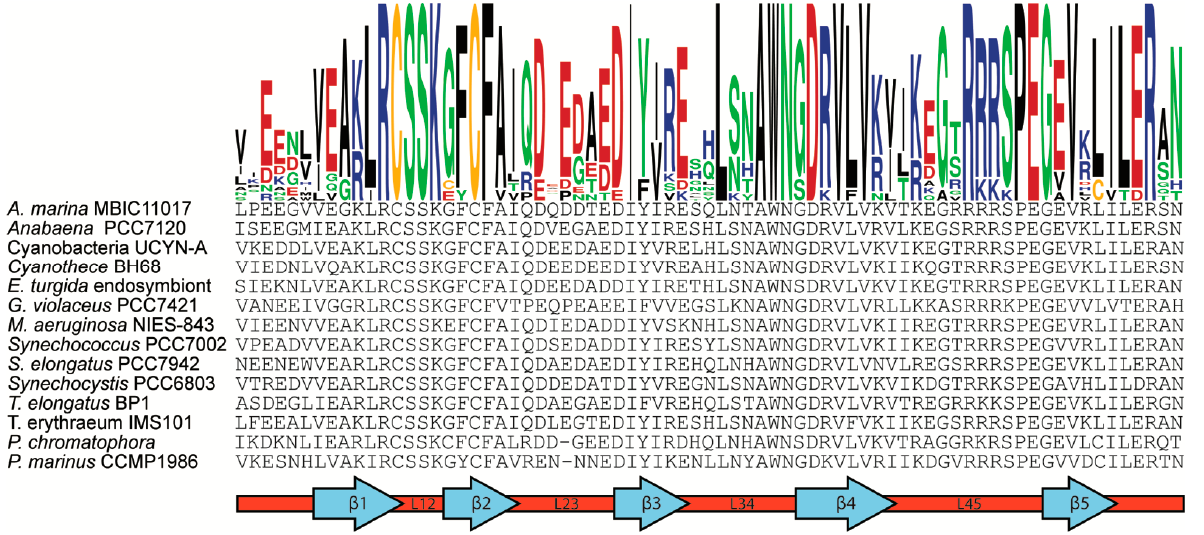
Figure 3. Annotated alignment of CSD1 OB-fold domain from Zam proteins. Conservation is illustrated with a sequence logo colorized by amino acid class (Black = Hydrophobic, Green = Polar, Red = Acidic, Blue = Basic, Yellow = Cysteine). The position of canonical OB-fold secondary structures within the sequence are annotated below. Β -strands are labeled ( β 1– β 4) with the intervening loops described by the strands they connect.